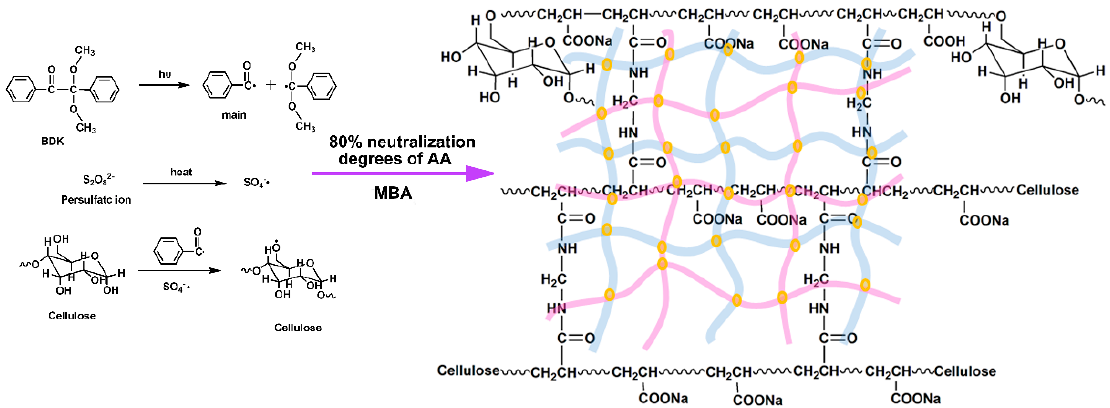
Figure 1. Schematic illustrations of the preparation of soybean dregs-Poly(acrylic acid)